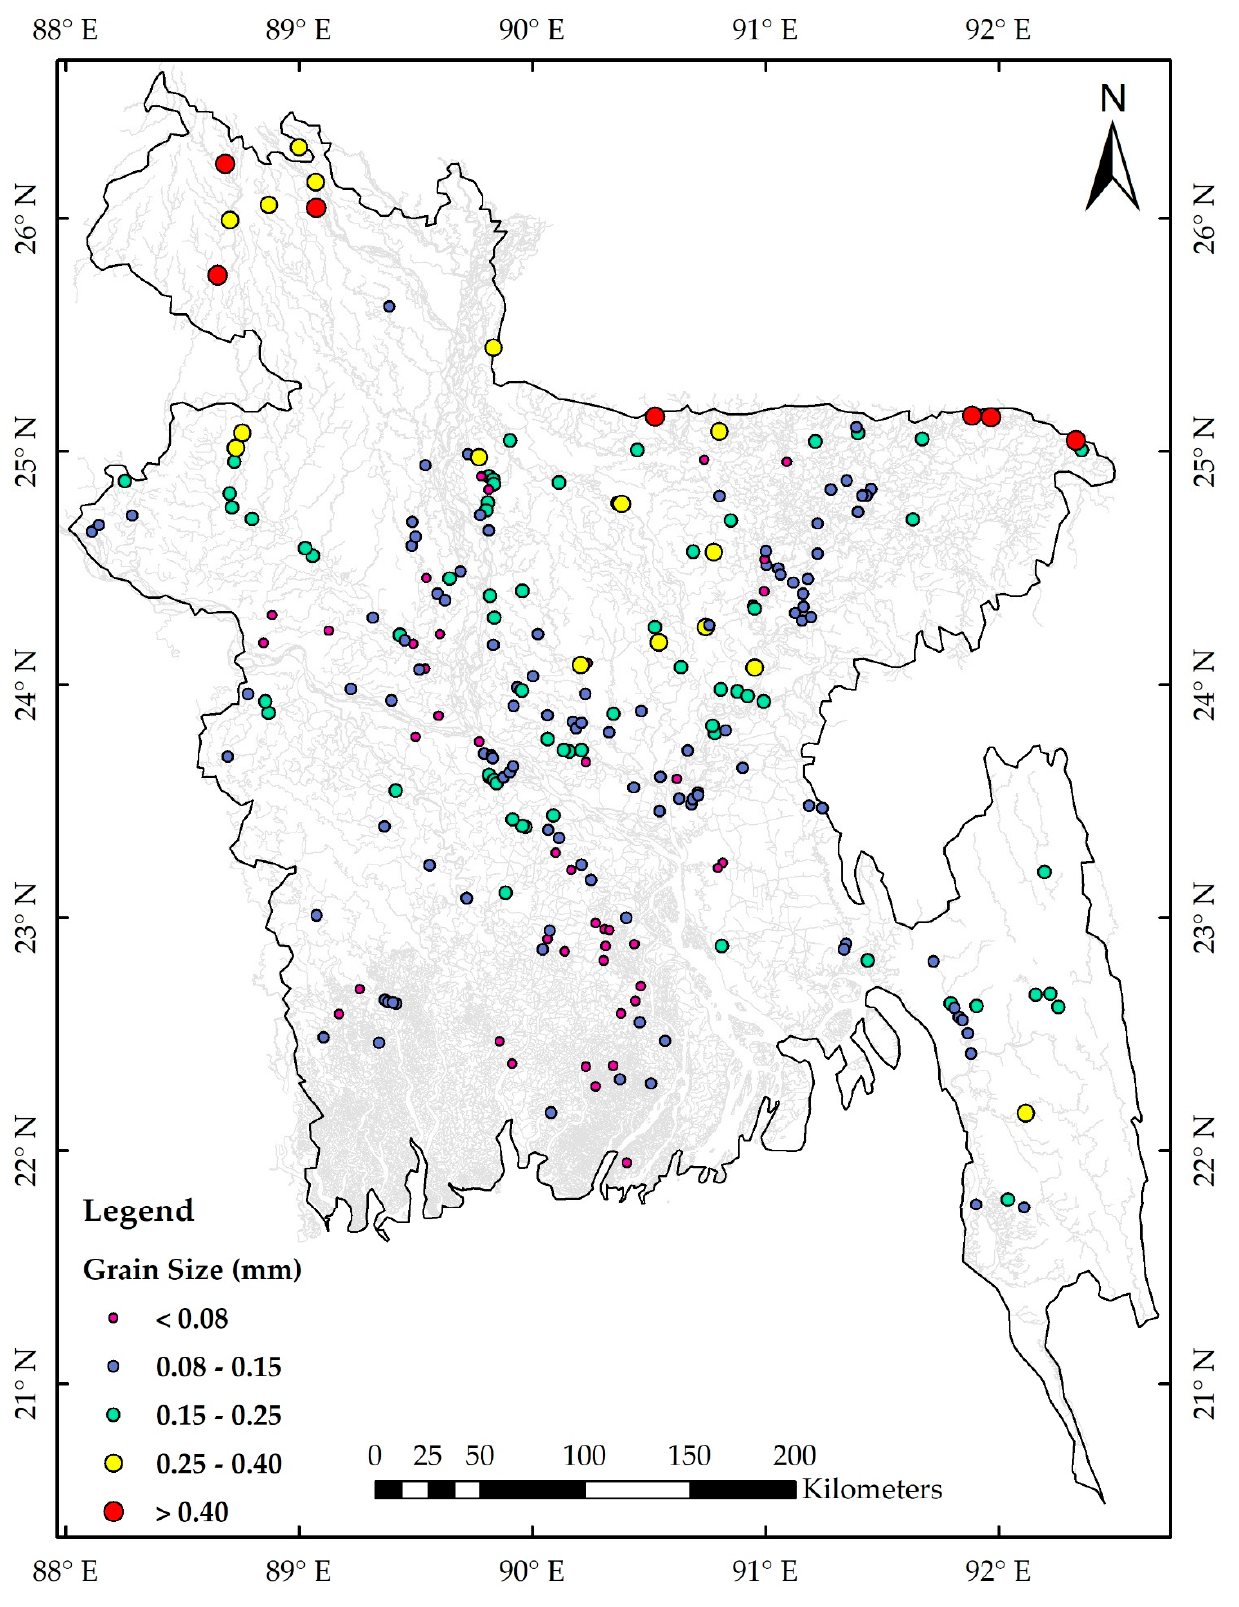
Figure 5. Grain size distribution of the bed materials of the Bangladesh rivers.